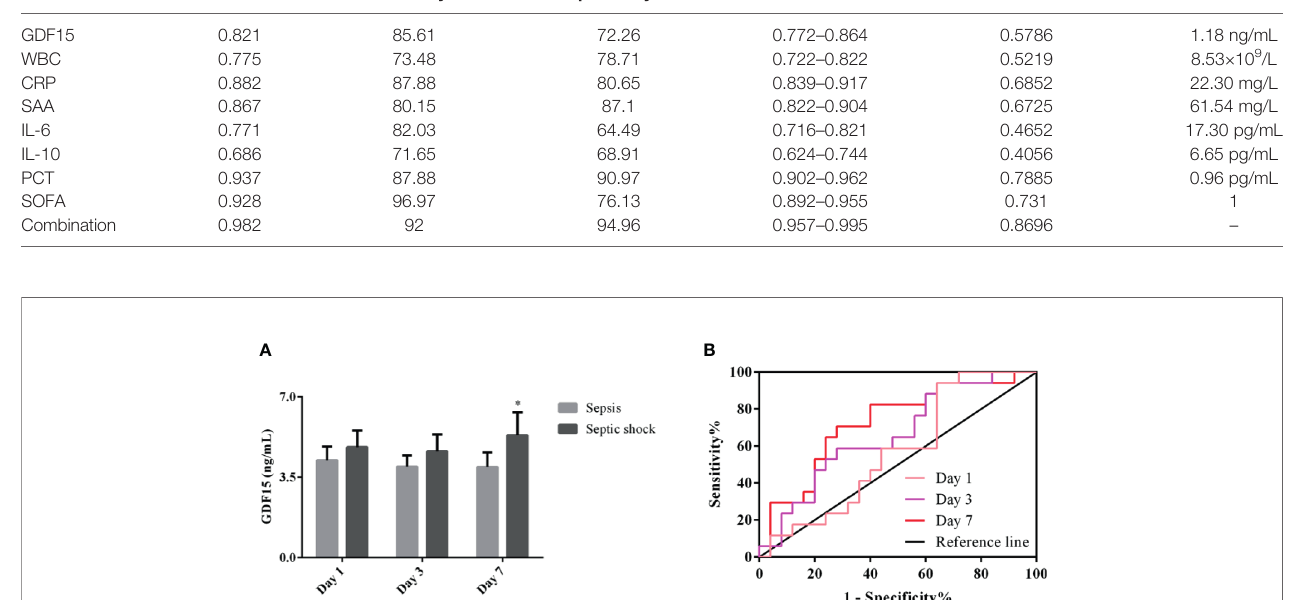
TABLE 3 | ROC curve analysis of GDF15 combined with in fl ammatory markers and SOFA in the diagnosis of sepsis. AUC